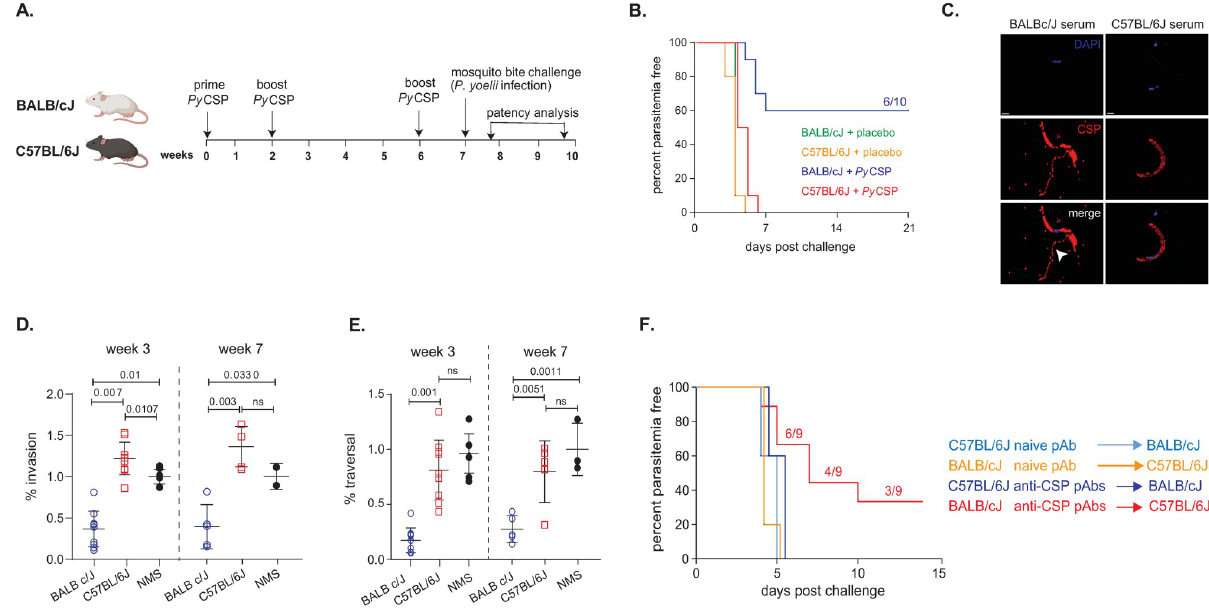
Fig 1. The Py CSP-immunization in BALB/cJ and C57BL/6J mice delays blood stage patency and confers protection only in the prior. A. Immunization and challenge regimen. B. Immunized BALB/cJ and C57BL/6J were challenged with P . yoelii infected mosquitoes and patency assessed day 3 through day 21. The Kaplan-Meier Survival plots represent percentage parasitemia free mice over time. Data are from 10 mice/condition across 2 independent experiments. 6 out of 10 PyCSP -immunized BALB/cJ mice (blue line) remained parasitemia free. C. Immunofluorescent images of neutralizing antibody induced CSP shedding in P . yoelii sporozoites. Sporozoites were incubated with purified serum antibodies, and fluor-coupled mAb 2F6 was used to detect CSP. Nuclei were identified by DAPI staining. Shedding of CSP was induced by BALB/cJ antibodies (white arrow), but not in C57BL/6J serum. ( D and E ) Inhibition of sporozoite invasion and traversal. D ) BALB/cJ immune serum but not C57BL/6J immune serum, significantly reduces sporozoite entry into Hepa1-6 cells. Sporozoites were pre-incubated with serum antibodies 10 mins prior to challenge on Hepa 1–6 cells and entry quantified by flow cytometry. ( E ). BALB/cJ antibodies inhibit fibroblast traversal, whereas C57BL/6J antibodies do not. Antibody- treated sporozoites were exposed to Human Foreskin Fibroblast cells (HFF-1) in the presence of Dextran-FITC for 90 mins, and traversal was quantified by flow cytometry. For ( D ) and ( E ), data represents mean values ± SE from three independent experiments: n = 3. p values were determined by comparing each treatment to untreated using one-way ANOVA for multiple comparisons tests. F. Sterile protection from infection in C57BL/6J mice can be achieved by passive administration of purified polyclonal antibodies from Py CSP-immunized BALB/cJ mice. Na ï ve BALB/cJ (n = 5) and C57BL/6J (n = 9) were passively transferred (i.p.) with 90 μ g of Py CSP antibodies from Py CSP-immunized C57BL/6J (blue) and BALB/cJ (red) mice, respectively. Five days post antibody passive transfer, mice were challenged with mosquito-bites from 15 Py- infected mosquitoes and the blood stage patency is monitored for 2 weeks. Na ï ve BALB/cJ (n = 5) and C57BL/6J (n = 5) that were passively transferred with purified polyclonal antibodies from na ï ve C57BL/6J (light blue) and BALB/cJ (orange) mice, respectively were used as controls. Data analyzed by Two-way ANOVA and p values were obtained by Tukey’s multiple comparison